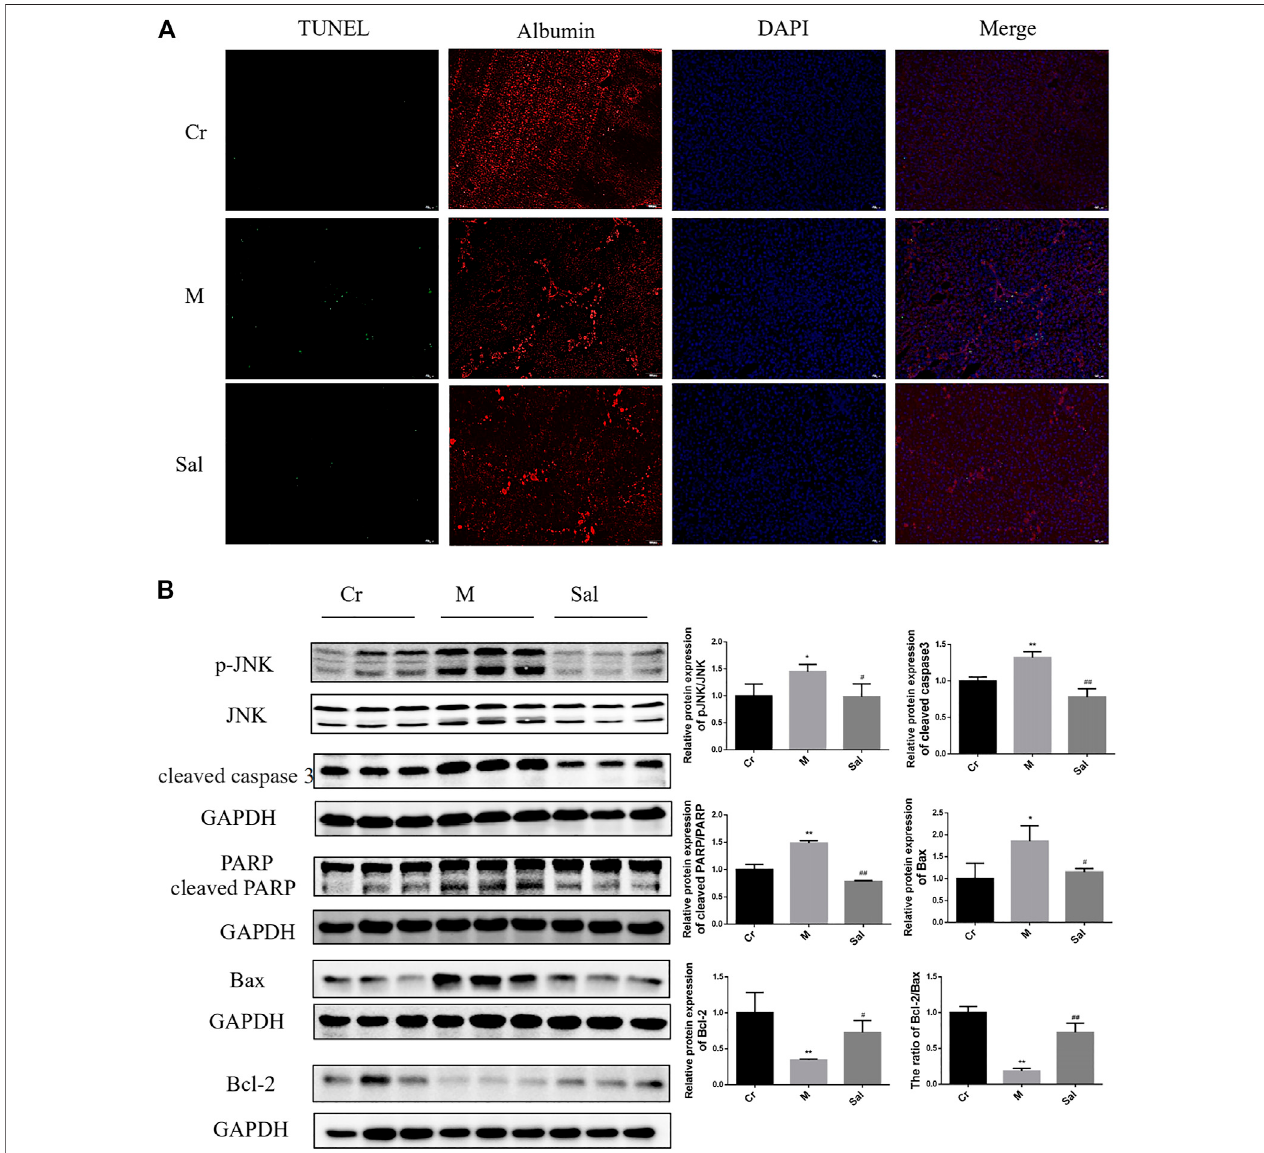
FIGURE 2 | Effect of Sal on apoptosis of hepatocytes in mice with liver fi brosis induced by CCl 4 . (A) : Immuno fl uorescence staining of TUNEL and Albumin ( × 100). (B) :EffectsofSalon theexpression ofp-JNK, cleaved caspase3,cleaved RARP,Bax,and Bcl-2inmice liverinducedbyCCl 4 .( n (cid:1) 15,* p < 0.05, ** p < 0.01, vs. Cr; # p < 0.05, ## p < 0.01, vs. M.). DAPI: 4 ′ ,6-diamidino-2-phenylindole; TUNEL: TdT-mediated dUTP nick end labeling.